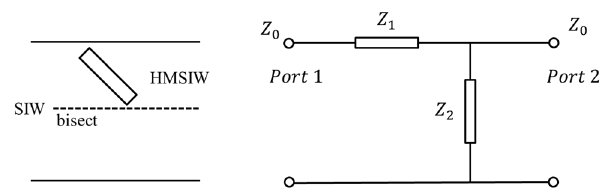
Figure 3. Equivalent circuit of the slot.